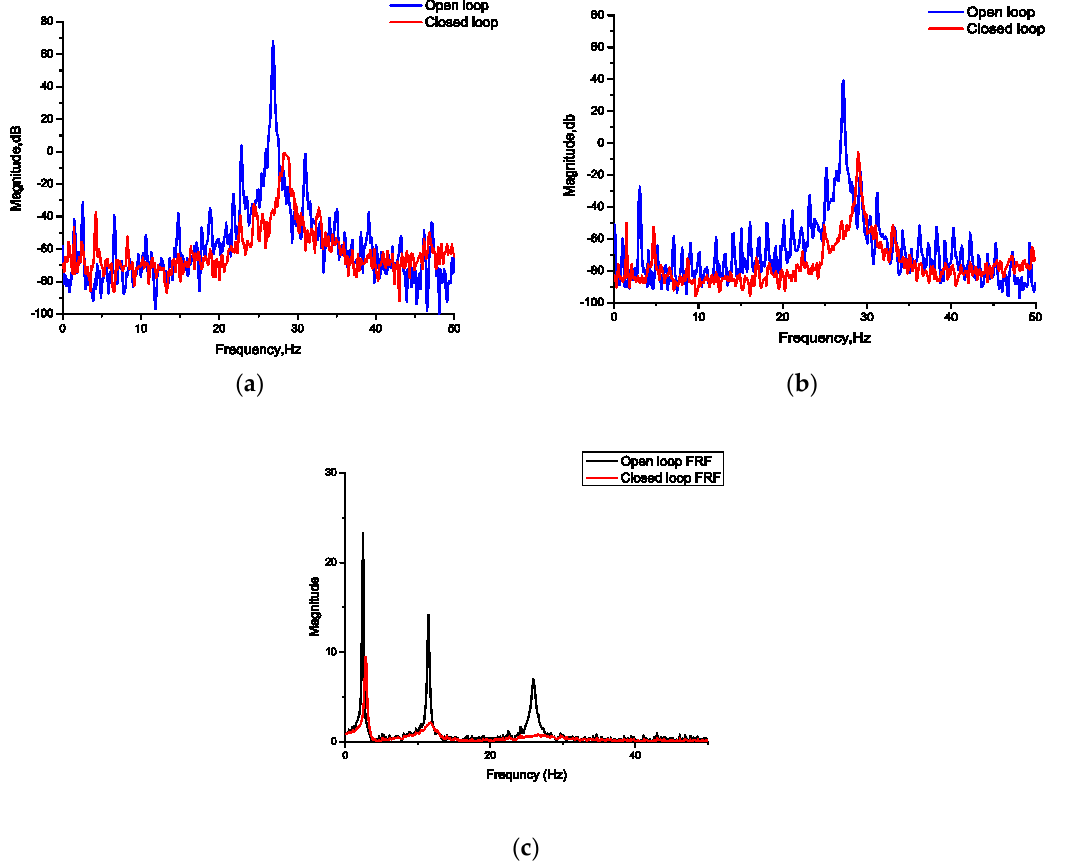
Figure 15. ( a ) Power spectrum of the self-sensing signal; ( b ) power spectrum of the acceleration signal; ( c ) comparison between the frequency response function (FRF) of the open loop and the closed loop.